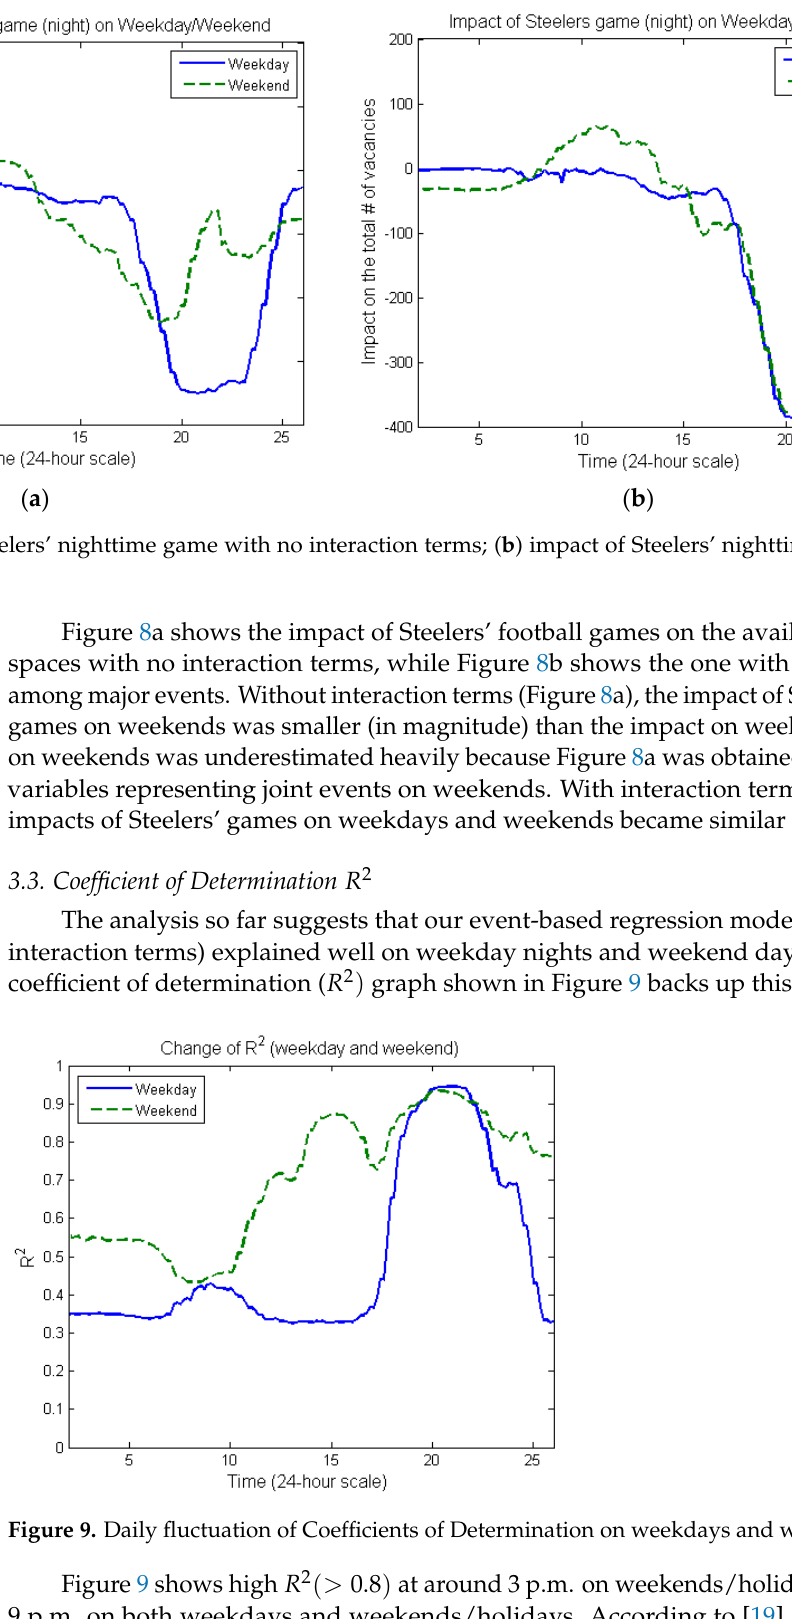
Figure 7. Impact of interaction terms that involved Steelers’ night game.